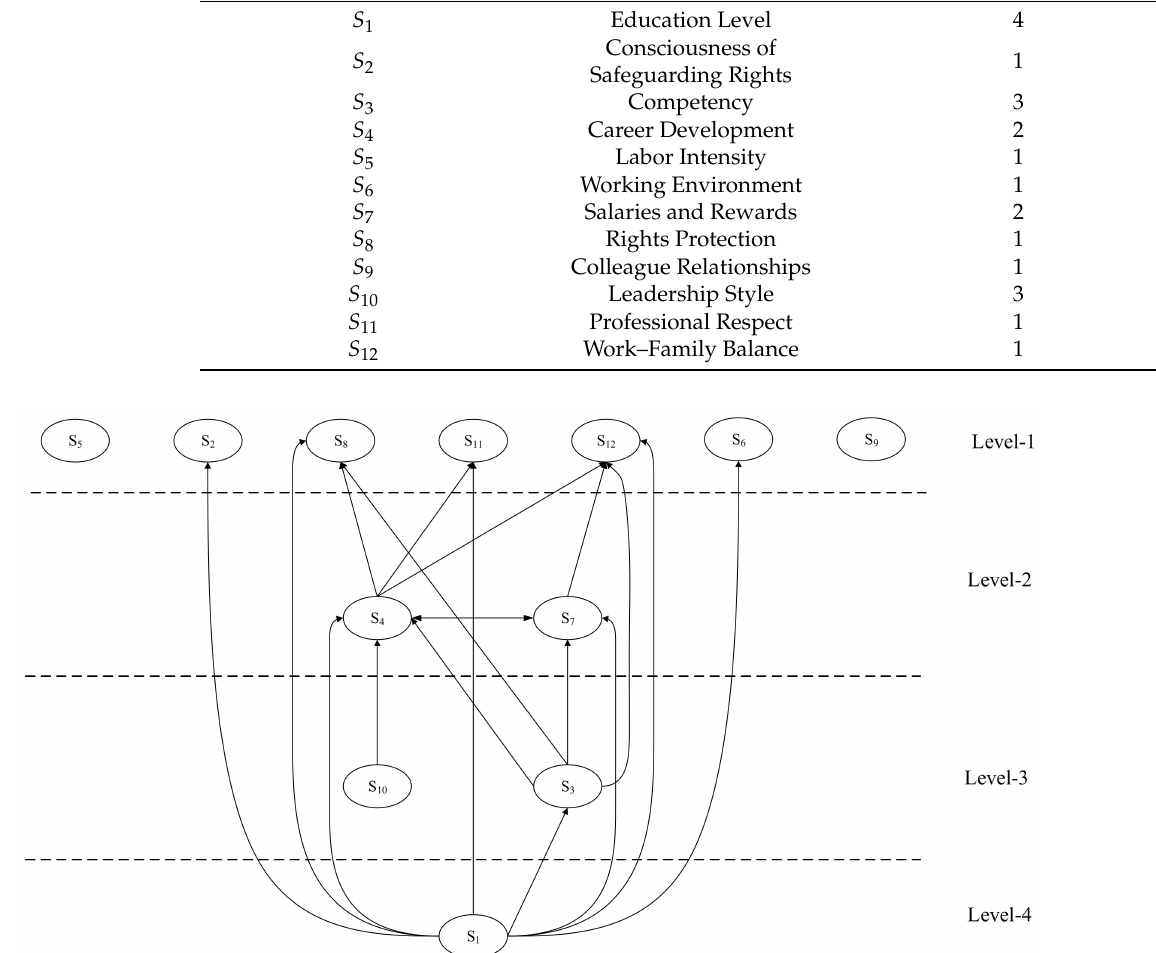
Figure 4. Multi-level hierarchical structure